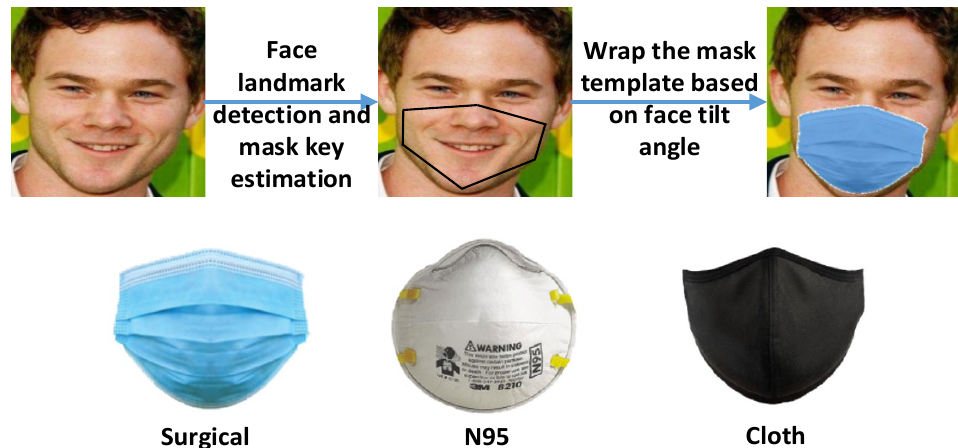
Figure 2. Masked face simulation flow and mask template. We used face landmark detection technology to synthesize different types of masks on the training images to increase the training data of masked face recognition model.